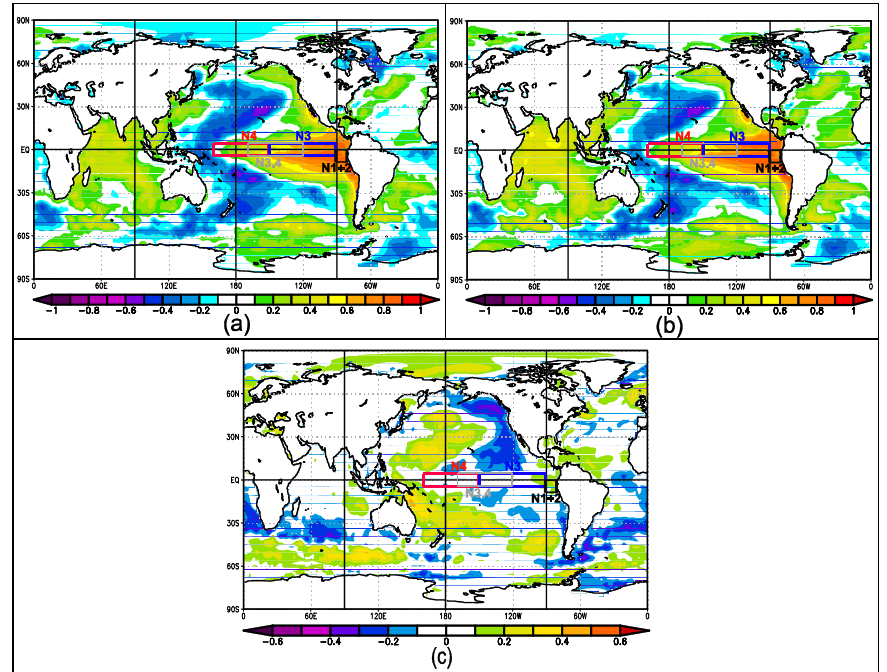
Figure 3. Spatial field of annual correlations between Sea Surface Temperature (SST) and ( a ) maximum temperature (TX), ( b ) minimum temperature (TN), and ( c ) precipitation (PP) in Lima. Niño SST indices corresponding to the regions Niño 1+2 (N1+2), Niño 3 (N3), Niño 3.4 (N3.4), and Niño 4 (N4). Analysis carried out for Hipolito Unanue (HU) station during the period 1968–2013. NCEP/NCAR Reanalysis. Source: NOAA/ESRL Physical Sciences